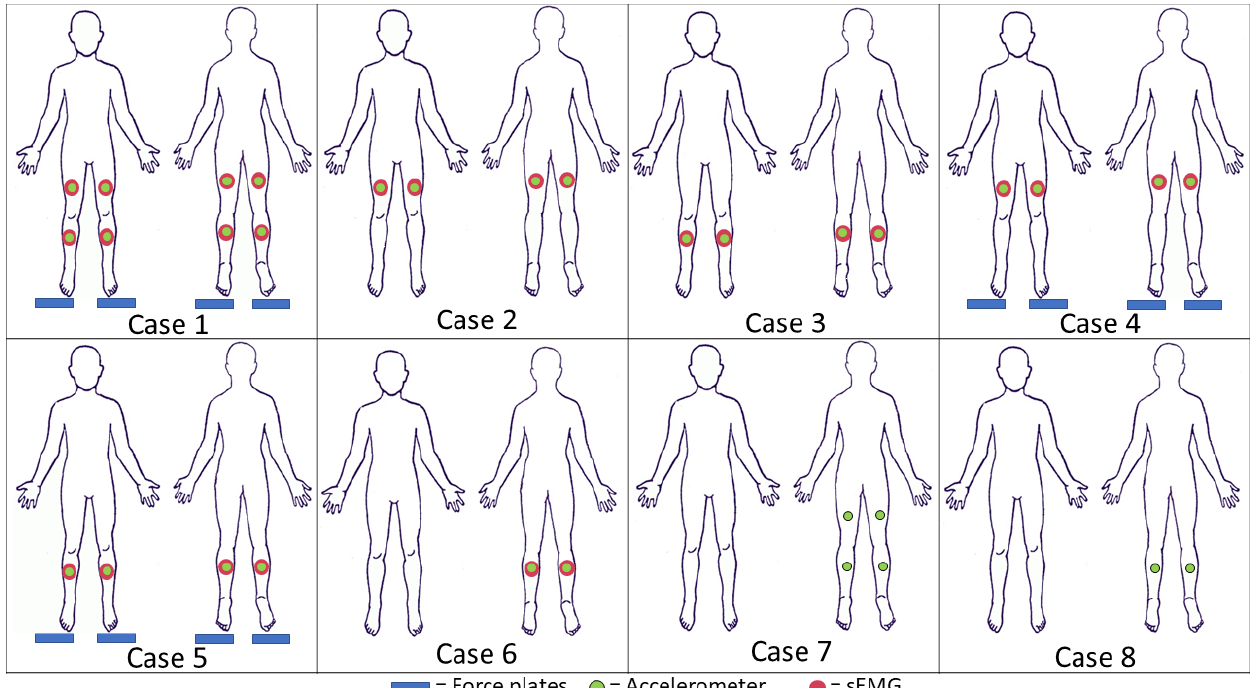
Figure 3. Locations of sensors during ablation. Case 1 includes all sensors. Case 2 includes sensors on the upper leg. Case 3 includes sensors on the lower leg. Case 4 includes sensors on the upper leg and the force plate. Case 5 includes sensors on the lower leg and the force plate. Case 6 includes sensors on the gastrocnemius. Case 7 includes one accelerometer on each segment of the leg. Case 8 includes one accelerometer per